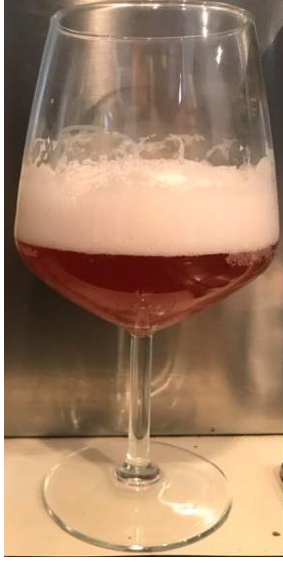
Figure 2. The hibiscus beer.